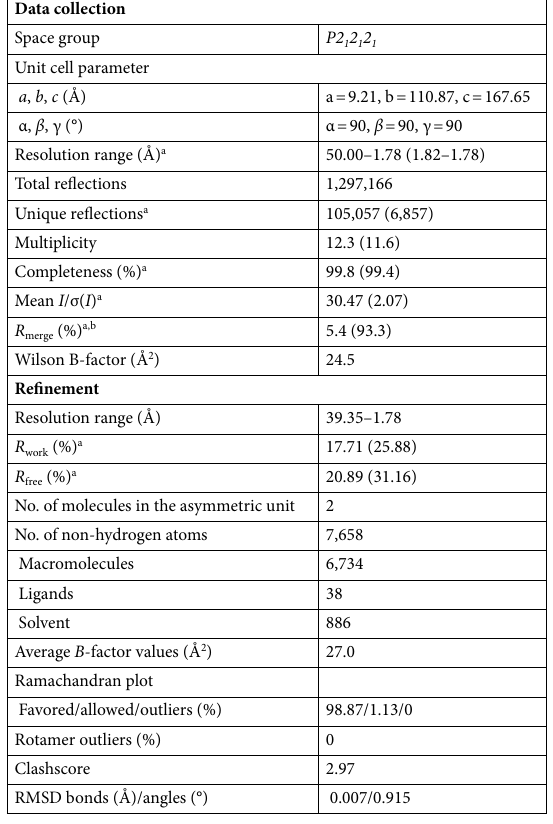
Table 1. Data collection and refinement statistics. RMSD root-mean-square deviation. a Values for